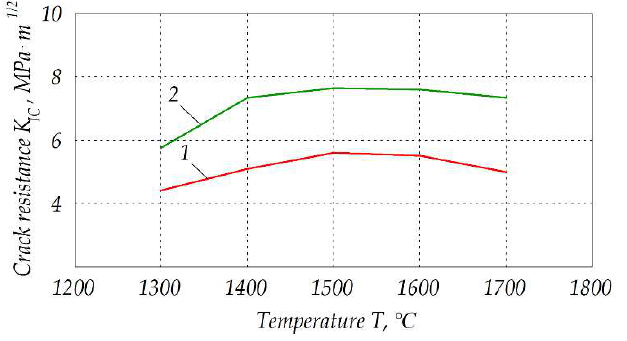
Figure 13. Fracture toughness of the composite Al 2 O 3 —20 wt.% SiO 2 —10 wt.% ZrO 2 sintered at different temperatures: 1 —traditional sintering, 2 —electroconsolidation.